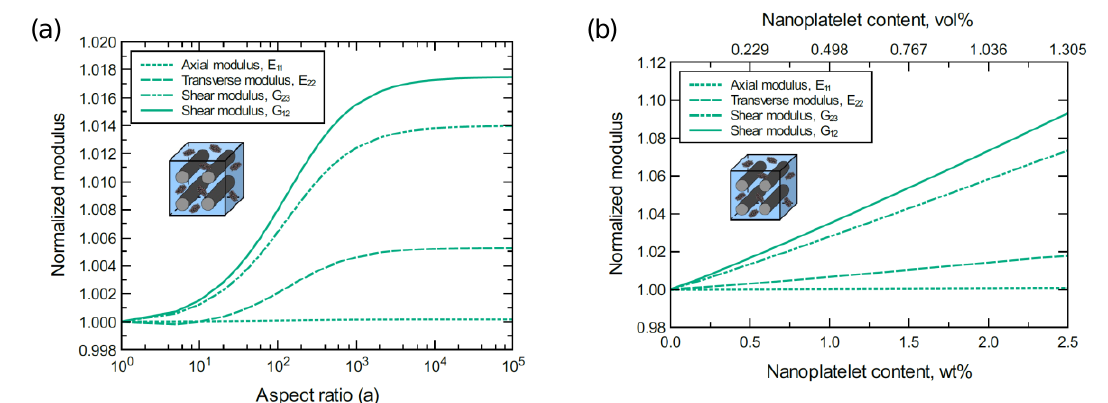
Figure 7. Predicted elastic and shear moduli for unidirectional CF/GO/epoxy for various nanoplatelet content and aspect ratio values; ( a ) axial elastic modulus 𝐸 11 , ( b ) transverse elastic modulus 𝐸 22 , ( c ) shear modulus 𝐺 12 , ( d ) shear modulus 𝐺 23 . The volume fraction of CF is 56%.